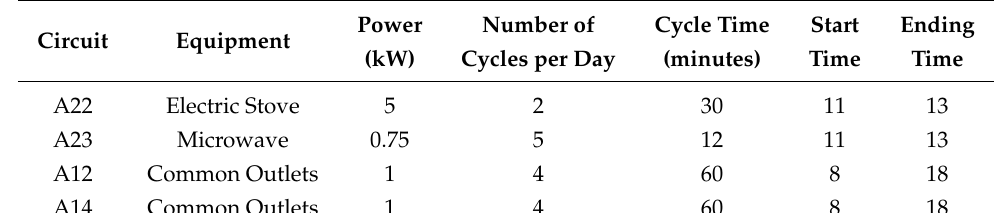
Table 1. Controllable loads of the microgrid.